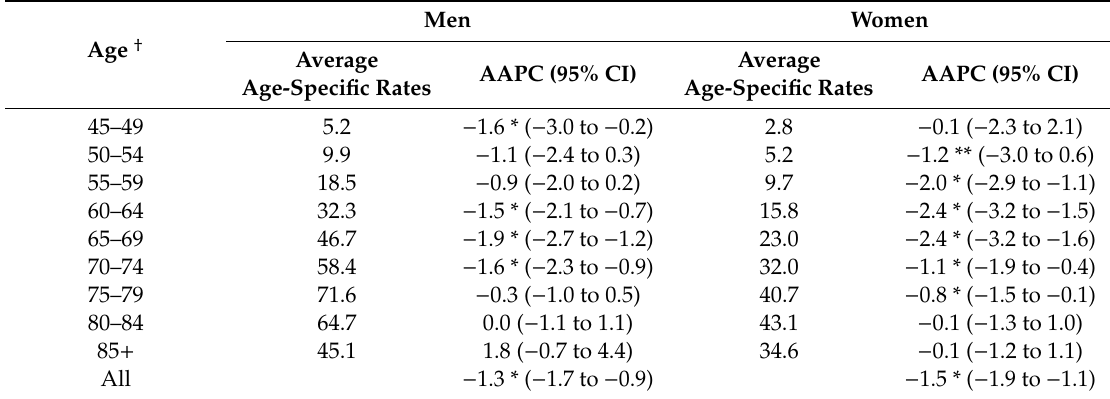
Table 2. Joinpoint analysis: trends in age-specific liver cancer mortality rates (per 100,000) in men and women in Serbia,